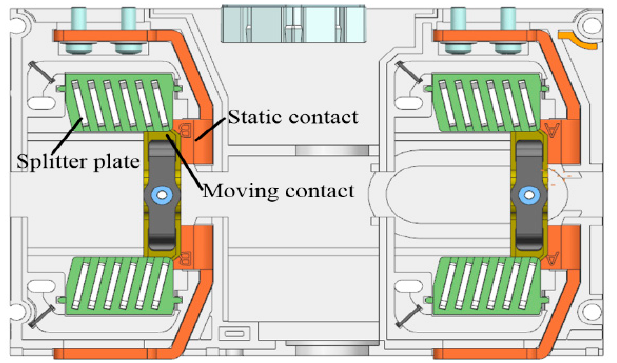
Figure 1. Arc-extinguishing chamber structure of disconnector.